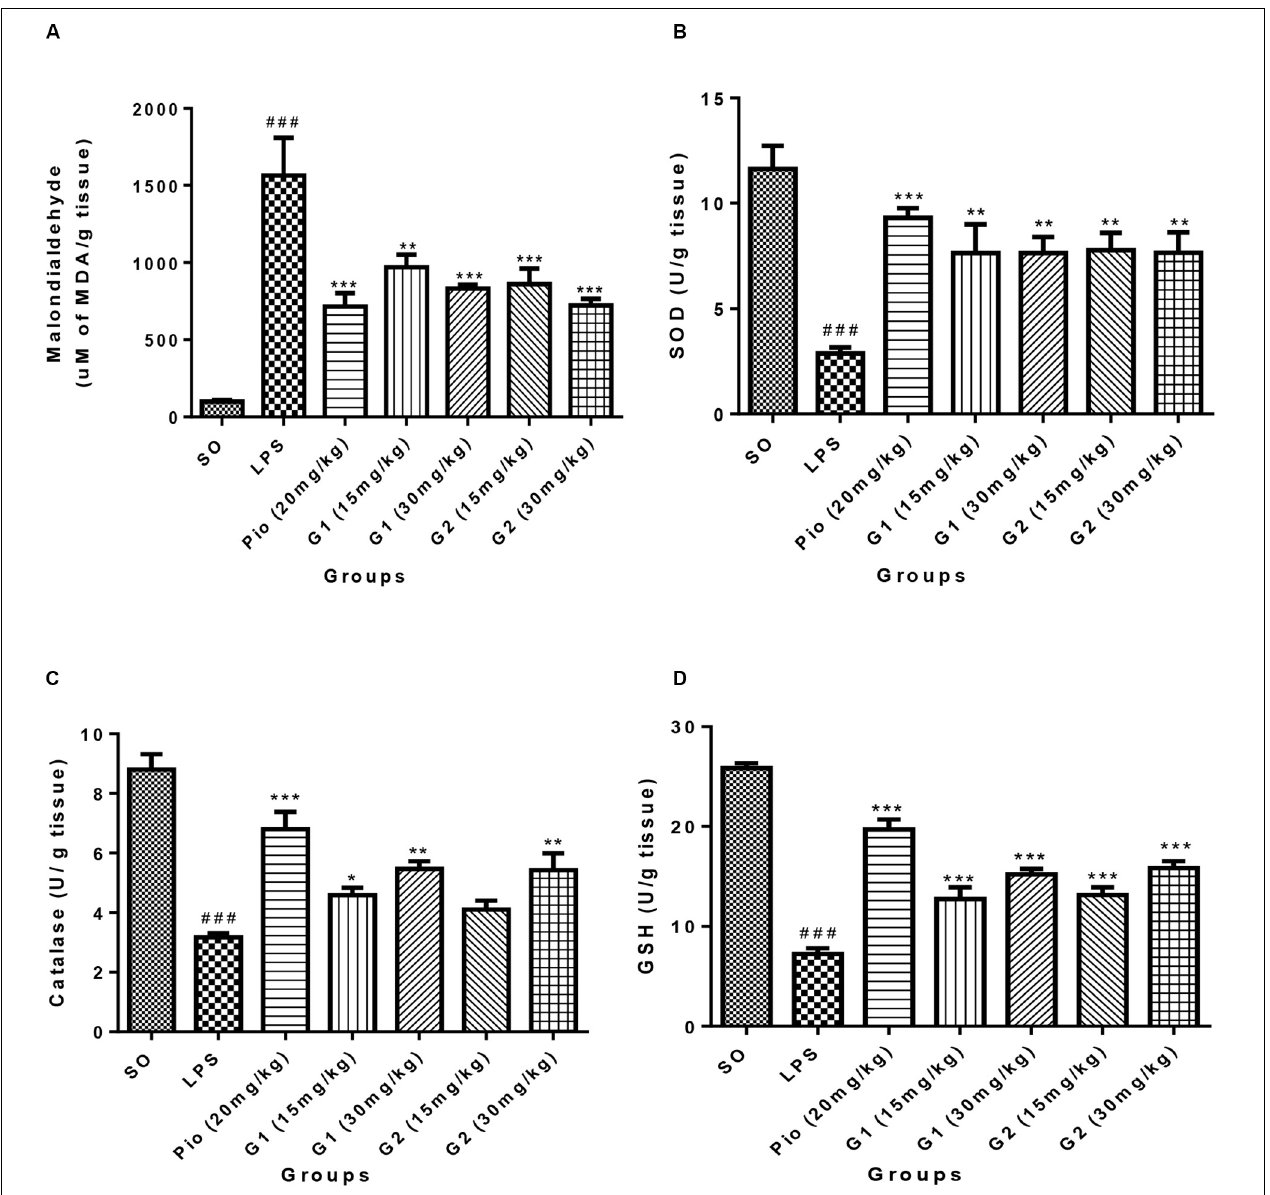
FIGURE 5 | Effect of novel glitazones on brain (A) malondialdehyde (LPO), (B) SOD, (C) CAT, and (D) GSH level in ICV-LPS-administered rats. Values are expressed as mean ± SEM. Statistical significance was determined by one-way ANOVA followed by Bonferroni’s multiple comparison tests. Superscript ### denotes p < 0.001 vs. SO; *, **, *** denote p < 0.05, p < 0.01, p < 0.001 vs. LPS, respectively. SO, sham operated; LPS, lipopolysaccharide; Pio, pioglitazone; G,